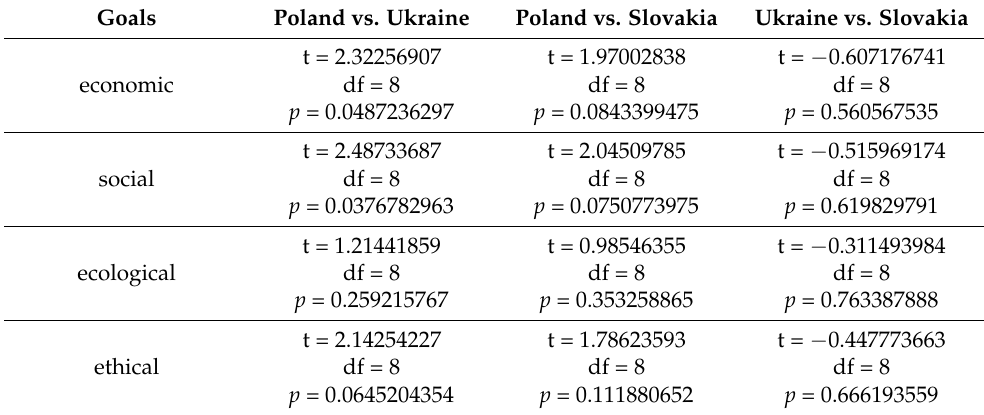
Table 14. Student’s t test results for independent samples in terms of perceiving the benefits of zero waste for society (for relations between respondents from Poland, Ukraine and Slovakia). Goals Poland vs.